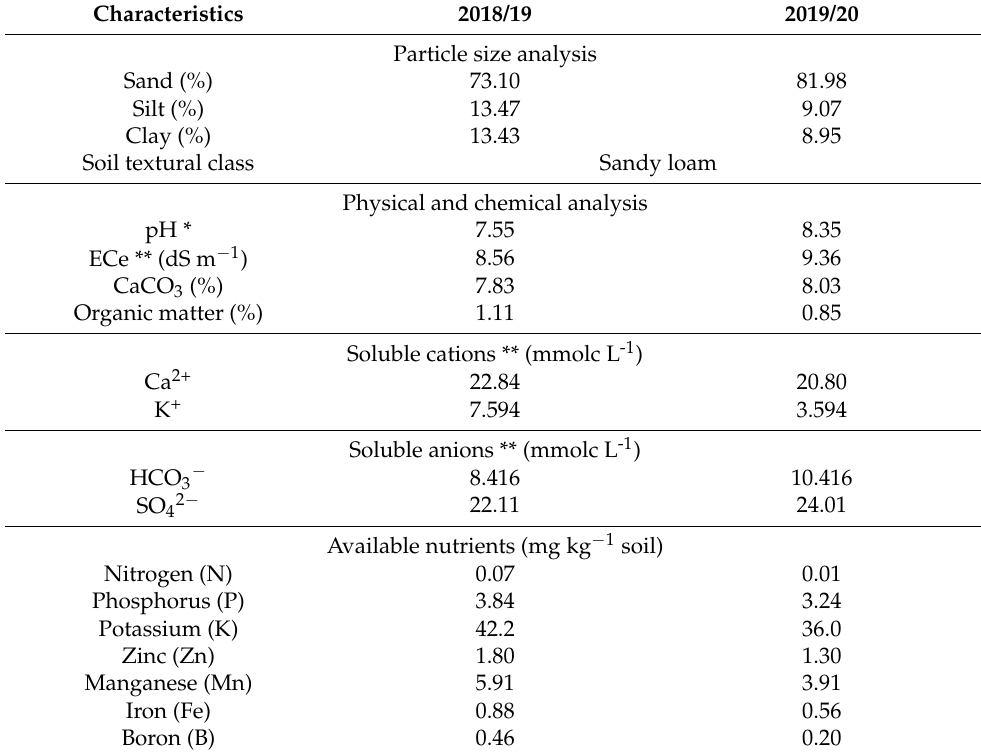
Table 1. Pre-season physicochemical characteristics of the tested soil (0–50 cm depth) for the 2018/19 and 2019/20 seasons.